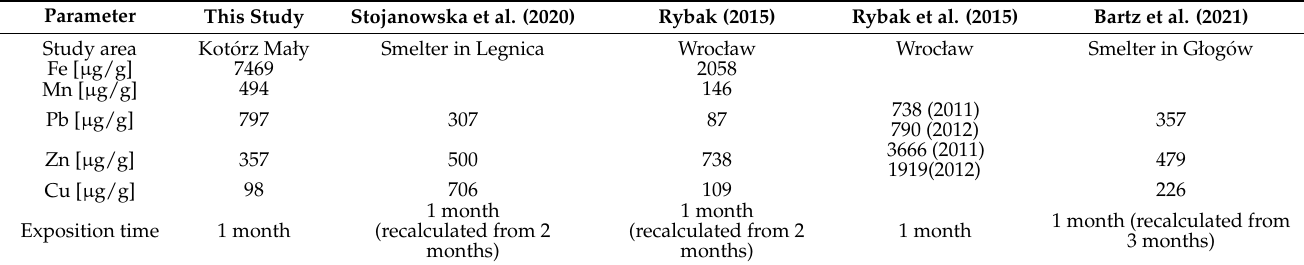
Table 4. Concentrations of average PTEs in this study and selected other researches (for easier comparison it was recalculated to one month of